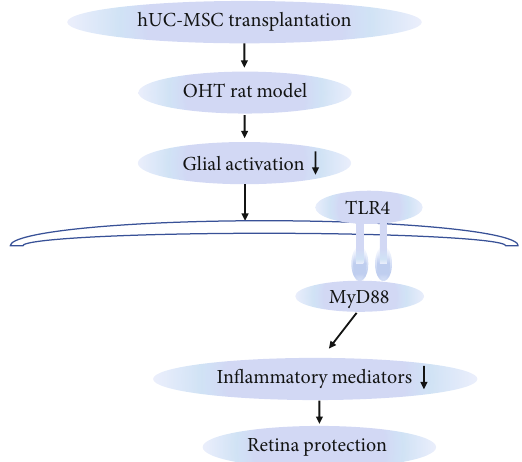
Figure 9: Schematic summary of the potential mechanisms for the neuroprotection of hUC-MSC transplantation in OHT rats. hUC- MSC transplantation attenuates the activation of glial cells and the TLR4-related neuroin fl ammatory signaling pathway in OHT rats, thereby leading to the retinal